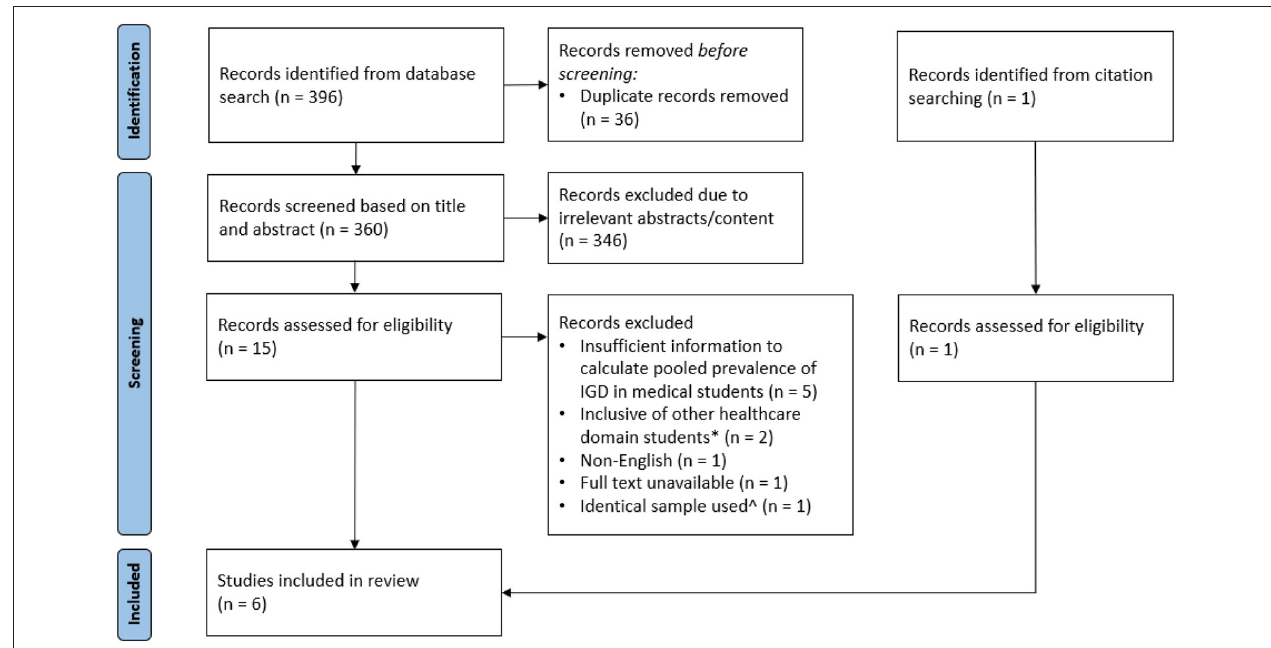
FIGURE 1 | PRISMA flow chart showing selection of studies.